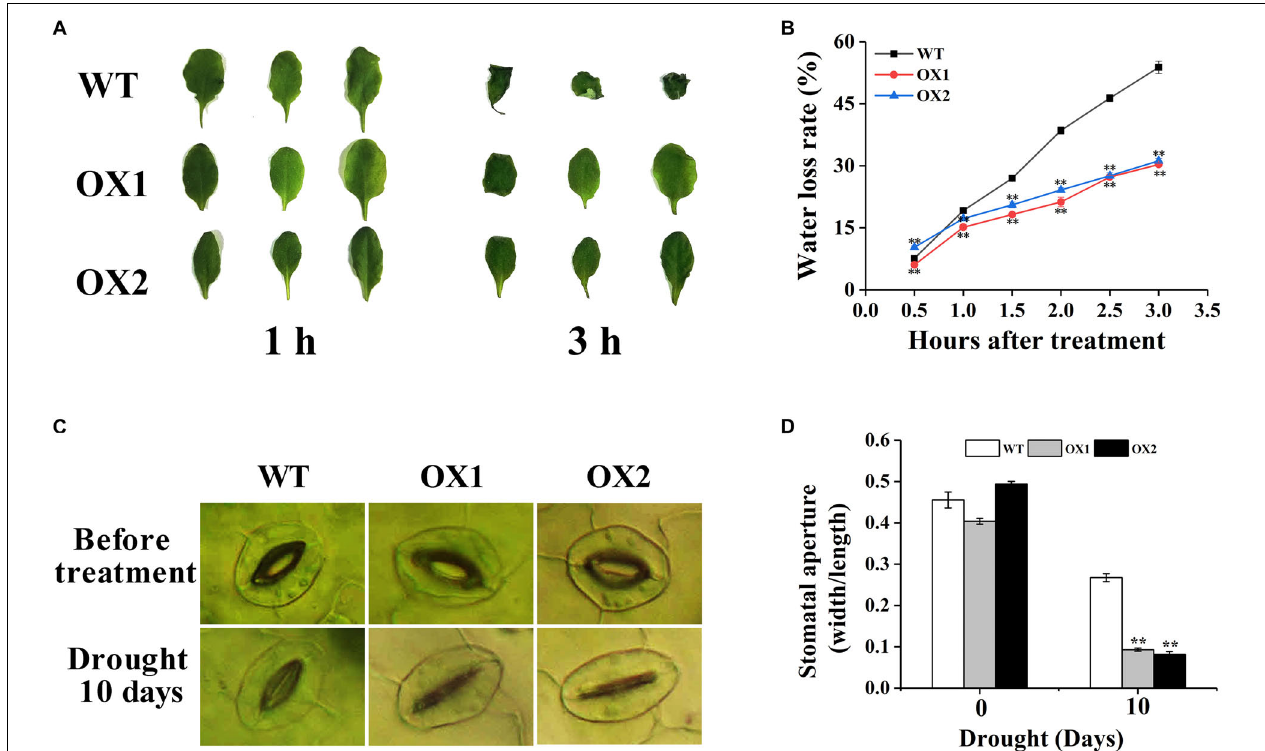
FIGURE 7 | OoNAC72 -OX plants exhibit reduced tolerance to water deficiency. (A) Phenotypes of detached leaves under water deficiency treatment for 1 and 3 h. (B) Water loss from detached rosettes of WT and OoNAC72 -OX plants. Values are means ± SD of three independent experiments. (C) Stomatal apertures of WT and OoNAC72 -OX plants. Scale bars = 30 µ m. (D) Stomatal aperture width/length ratios under dehydration conditions in 10 days. The stomatal aperture was measured by microscope. Values are means ± SD ( n = 50) in assays. Asterisks indicate statistically significant differences from WT. ∗ P < 0.05, ∗∗ P <